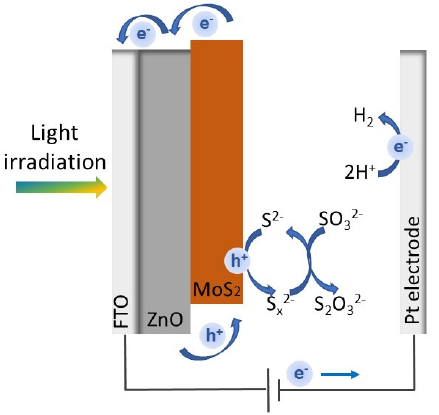
Figure 7. A schematic of the charge carriers’ reactions in a PEC splitting cell.